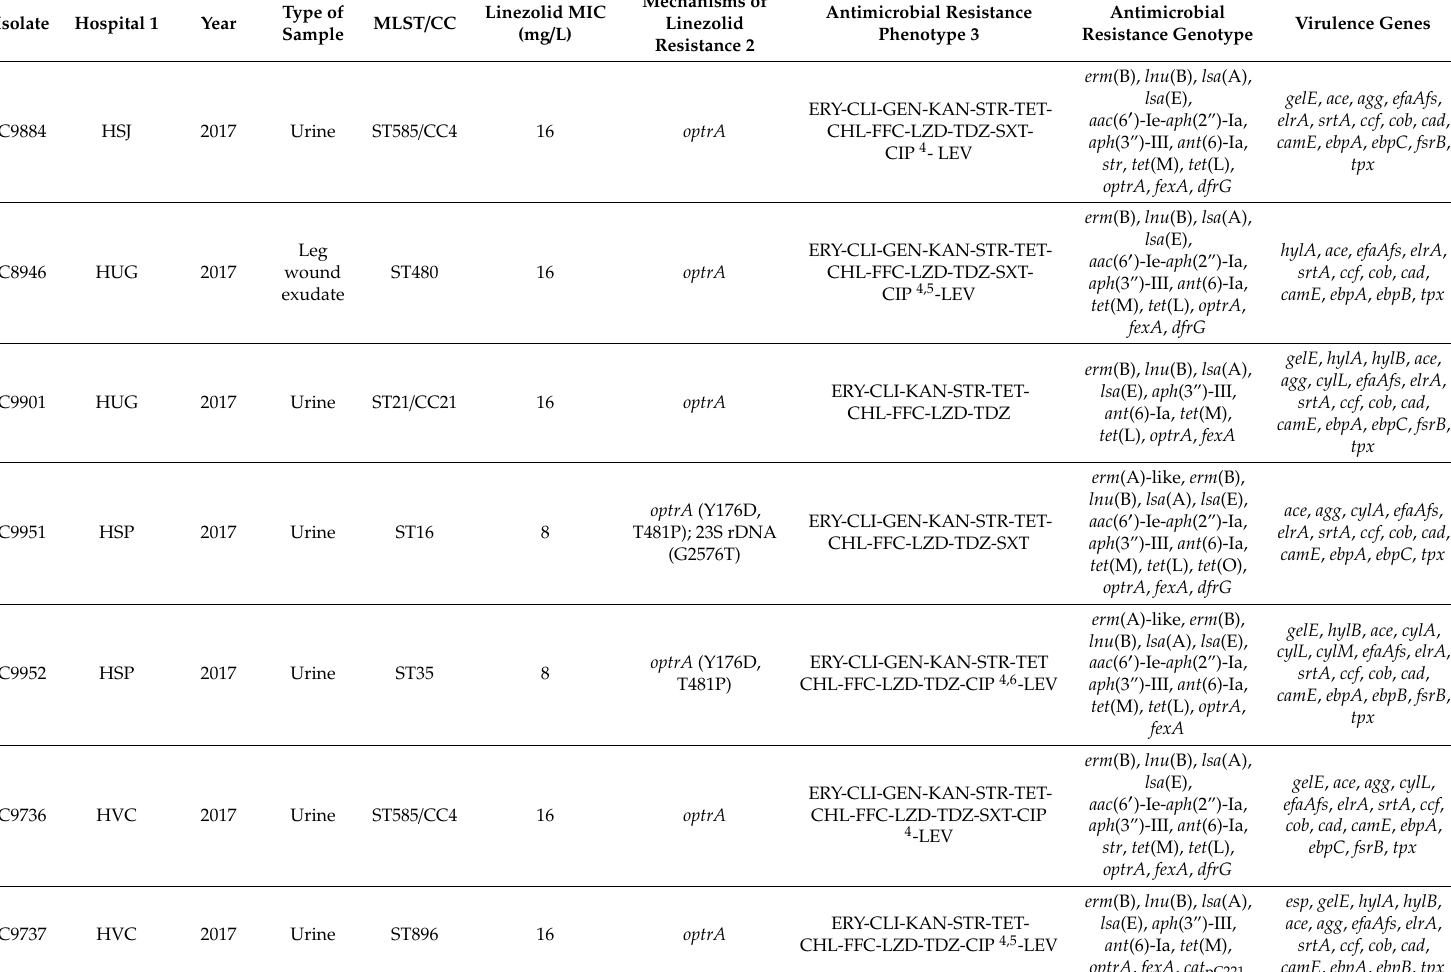
Table 1. Characterization of 13 clinical linezolid-resistant E. faecalis isolates investigated in this